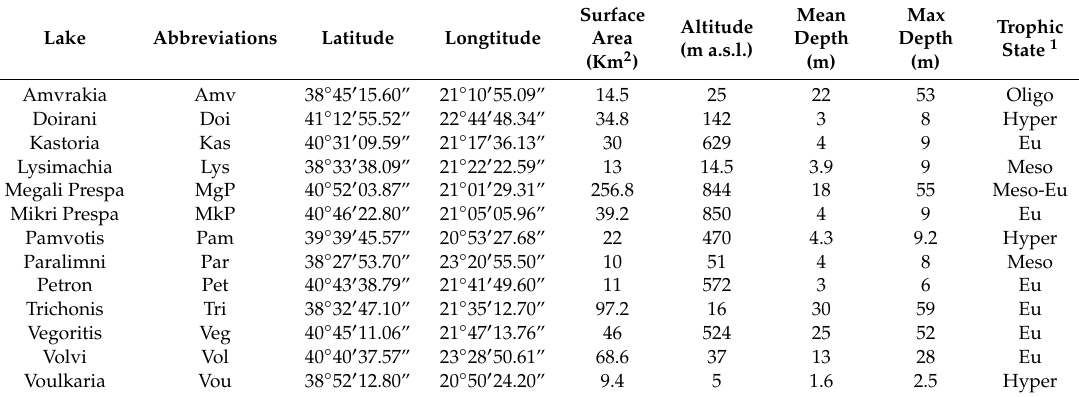
Figure 1. Map of Greece showing the location of the 13 studied lakes. Abbreviations are according to Table 1. Table 1. Topographic, morphological data and the trophic state for the 13 studied Greek lakes.